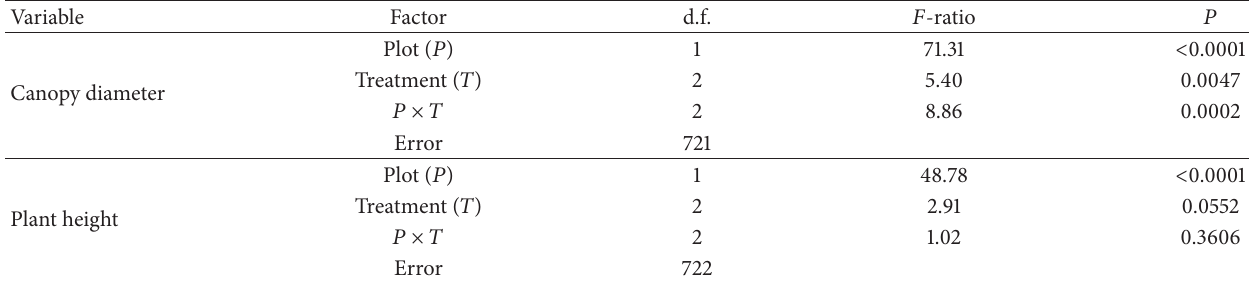
Table 1: Summary of the two-way ANOVAs for growth parameters measured in Ulex parviflorus plants after two growing seasons (October 2007). Treatments are no intervention, partial cut plus lopping, and salvage